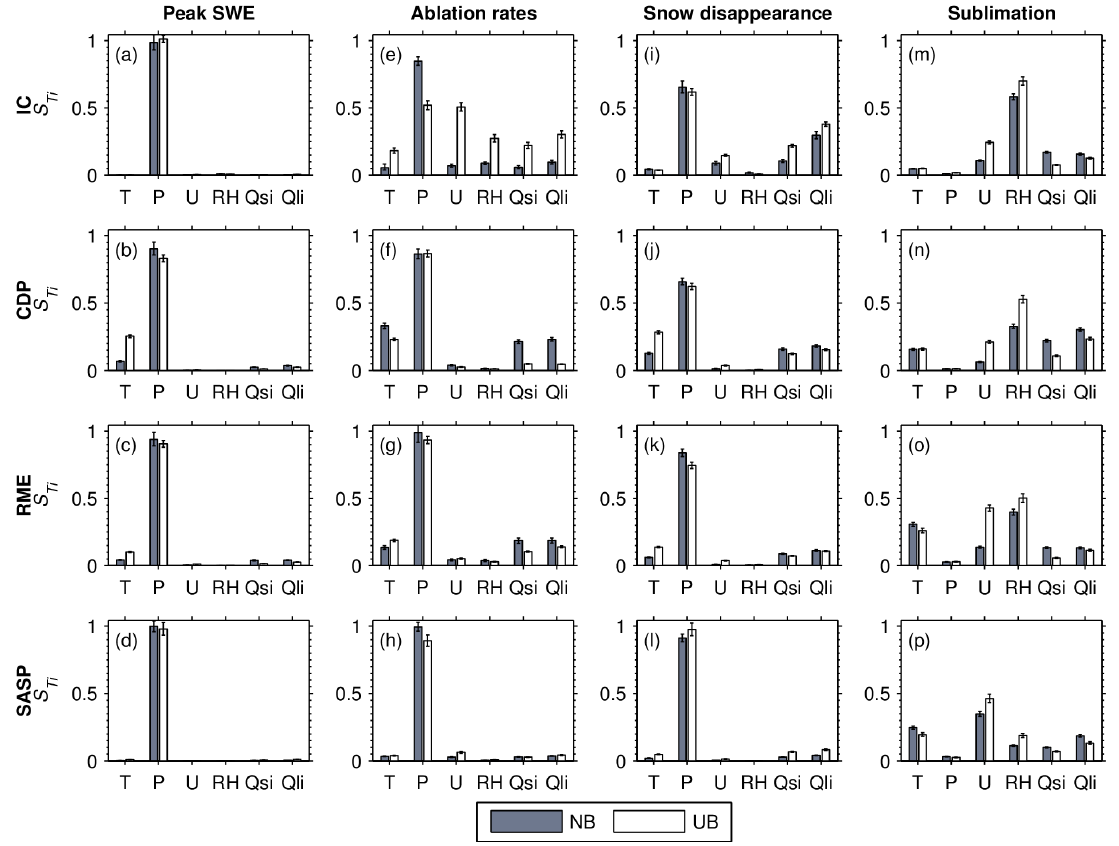
Figure 6. Same as Fig. 5, but comparing S T i values from scenarios NB and UB to test model sensitivity as a function of error probability distribution. UB considers uniformly distributed bias, while NB considers normally distributed